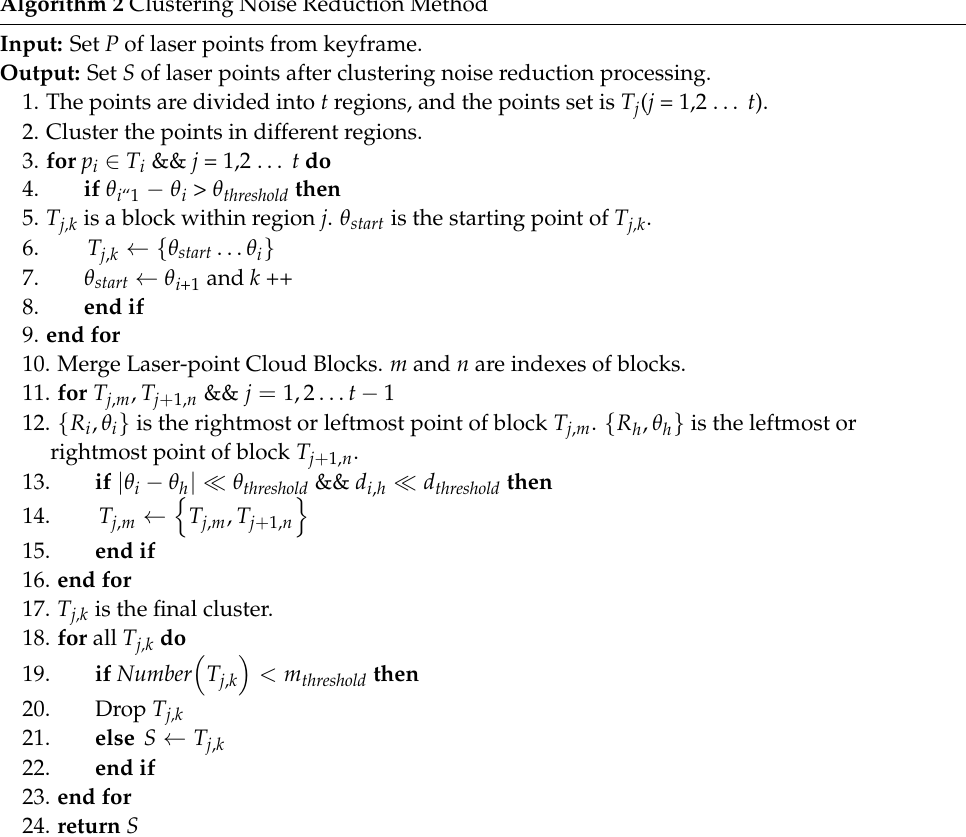
Algorithm 2 Clustering Noise Reduction